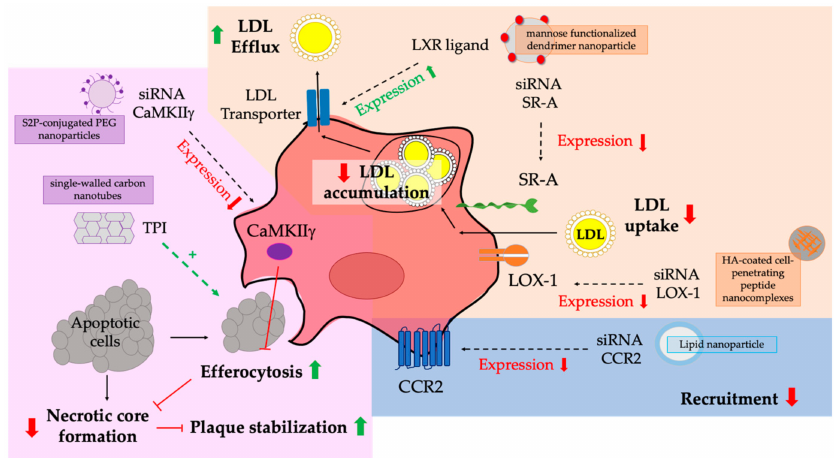
Figure 4. NPs to target and modulate macrophages to treat atherosclerosis. Expected therapeutic effects of functionalized NPs to fight atherosclerosis: (1) LDL uptake must be reduced, and the LDL efflux must be increased to reduce LDL accumulation (orange); (2) Macrophage recruitment must be blocked (blue); (3) Efferocytosis must be activated to prevent the formation of a necrotic core (violet). This figure shows nanoparticles-based strategies to target and treat macrophages for the treatment of atherosclerosis. LDLs: low-density lipoproteins; LXR: liver-x-receptor; siRNA: small interference RNA; SR: scavenger receptor; LOX-1: LDLs receptor 1; HA: Hyaluronic acid; CCR2: chemokine receptor 2; CaMKII γ : Ca 2+ /calmodulin-dependent protein kinase γ ; TPI: tyrosine phosphatase inhibitor